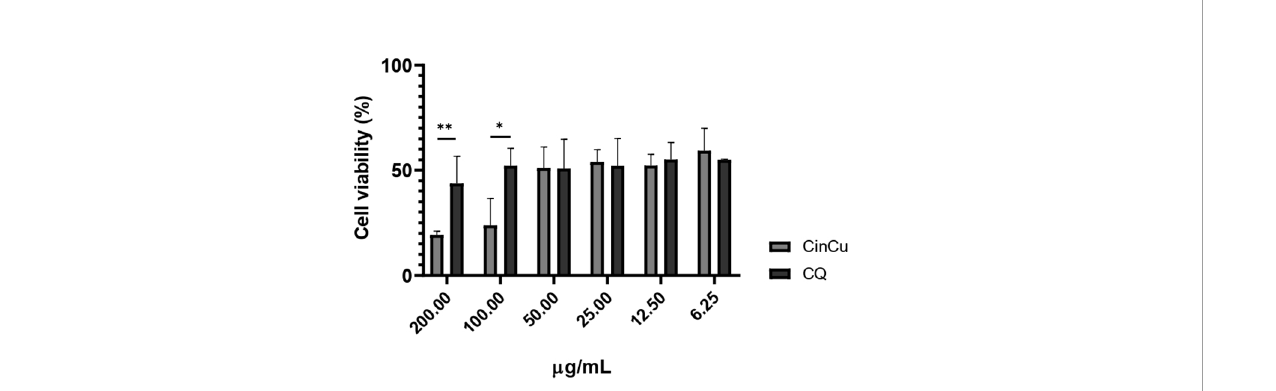
FIGURE 2 In vitro cytotoxicity analysis of CinCu and chloroquine in RAW264.7 cell line. CQ: chloroquine; CinCu: Copper-coordinated cinchonine. Results are presented as mean ± SD of three replicates. The data displayed here represents the concentrations of compounds that guarantee at least 50% cell viability (CC50). ** p<0.01; *